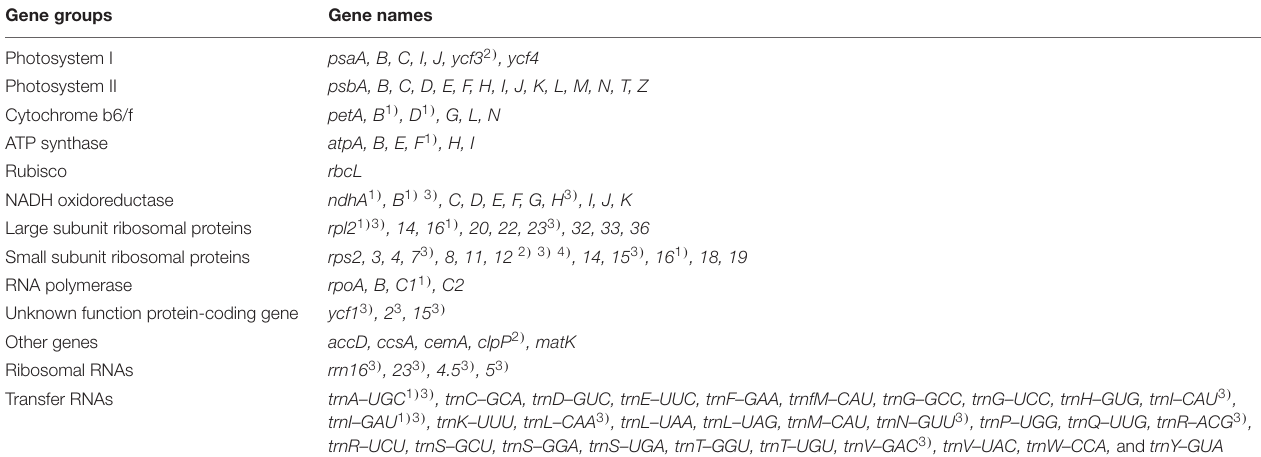
TABLE 2 | Genes in the plastid genomes of Trichosanthes species.